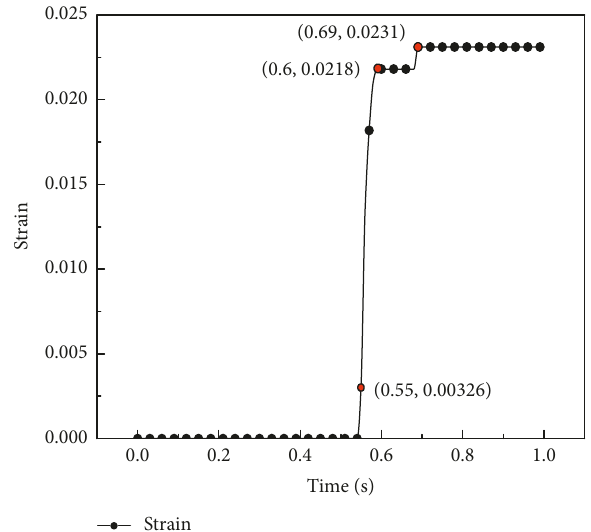
Figure 21: Time-history curve of the strain at impact